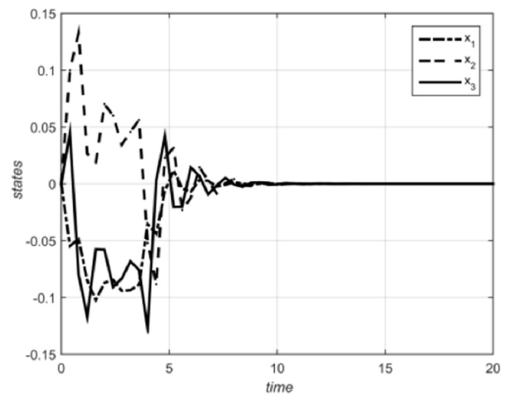
Figure 2. Trajectories of the states (the proposed approach).